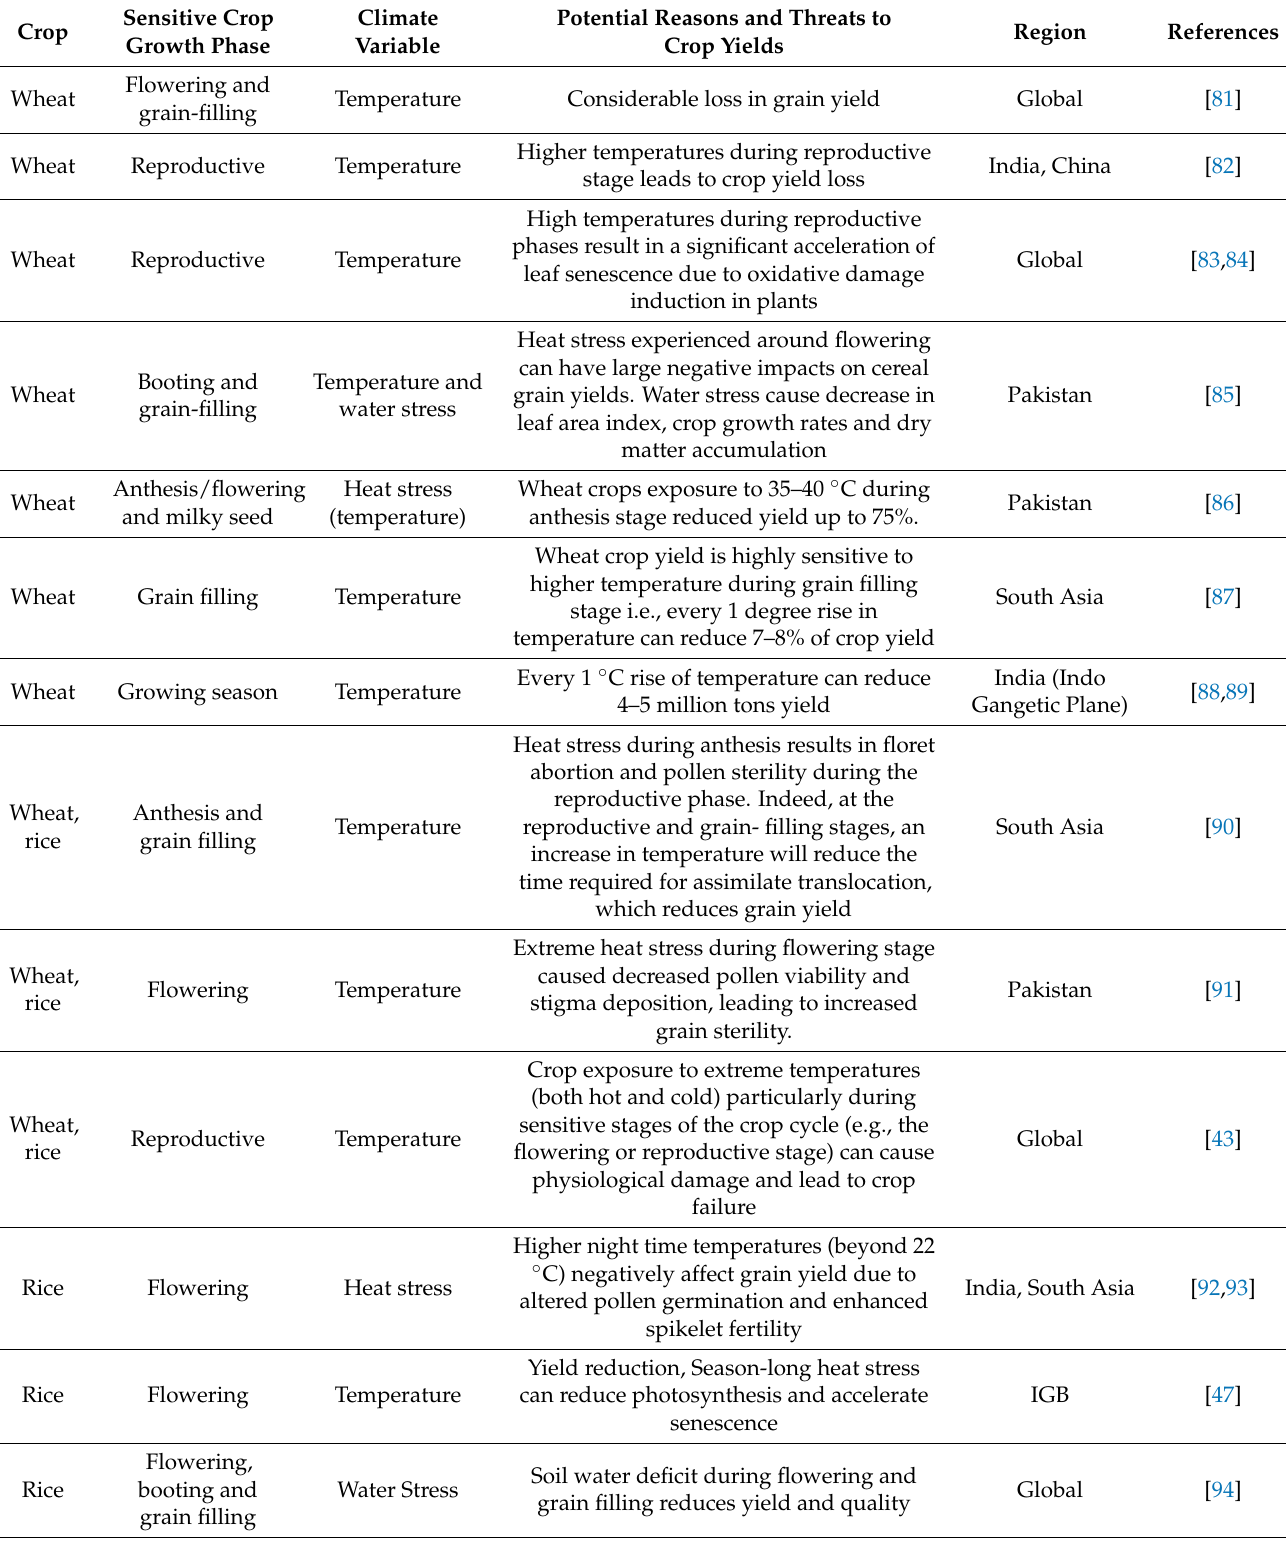
Table 4. Wheat and rice crops sensitivity to heat and water stress during crop growth phases based on literature review. It is pertinent to mention here that booting, heading and anthesis/flowering are sub-stages of reproductive phase. Whereas, milky, dough and grain filling are sub-stages of ripening